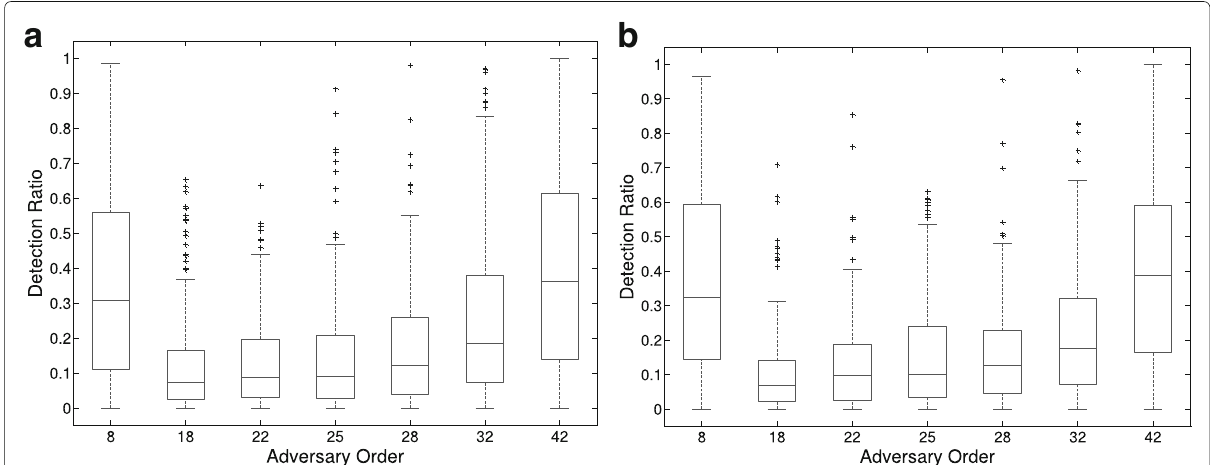
Fig. 11 Numeric simulation results using the single- and multi-watermark detection schemes with the same performance loss, different adversary system order, and a window size equal to 300. a Detection ratio regarding single-watermark for systems of order 25. b Detection ratio regarding multi-watermark for systems of order 25. a Detection ratio function with respect to the single-watermark for systems of order 25 against a parametric cyber-physical adversary using different adversary system order. b Detection ratio function with respect to the multi-watermark for systems of order 25 against a parametric cyber-physical adversary using different adversary system order